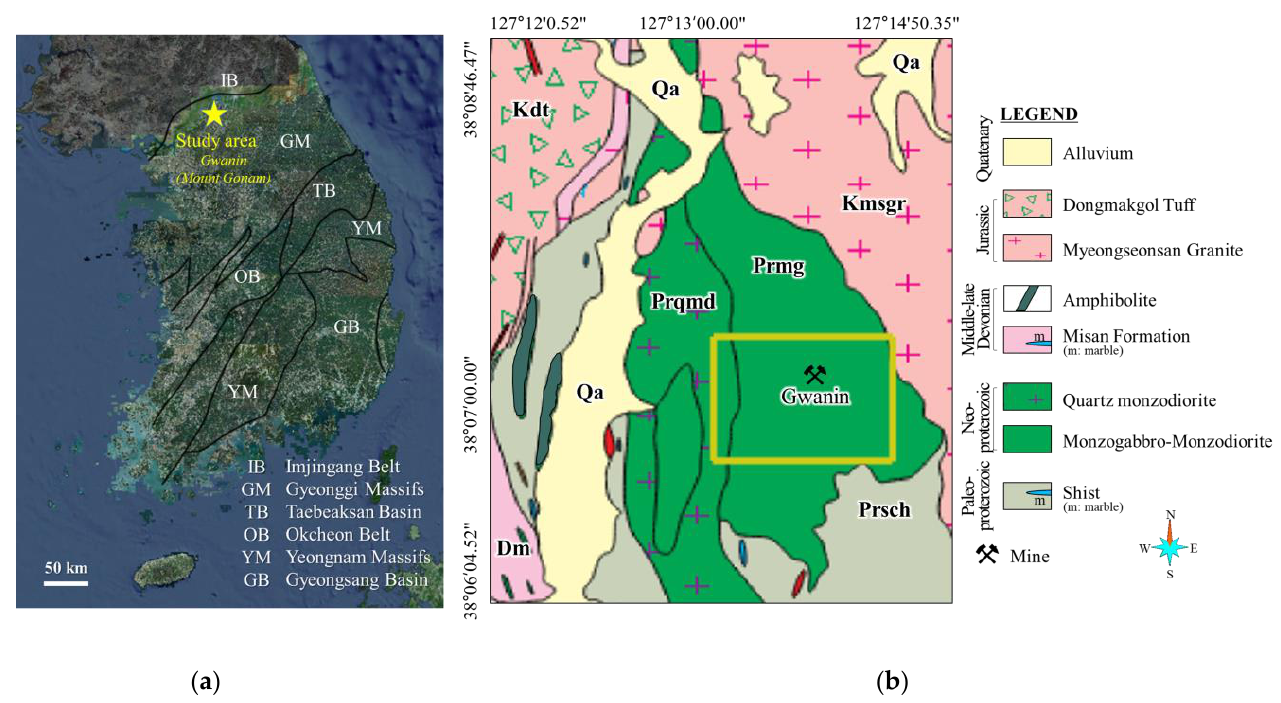
Figure 1. ( a ) General geological map showing the tectonostratigraphic units of the southern Korean Peninsula. Yellow star indicates the location of study area, Gwanin (Mount Gonam). ( b ) Geological map of Gwanin (modified from [24]). Yellow rectangle indicates the study area.